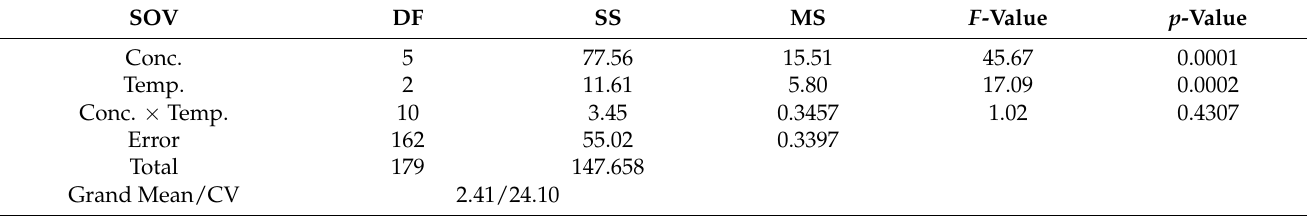
Table A5. Fecundity of M. persicae in relation to PeBC1 elicitor and temperature, (ANOVA). SOV DF SS MS F -Value p -Value Conc. Temp. Conc. ×